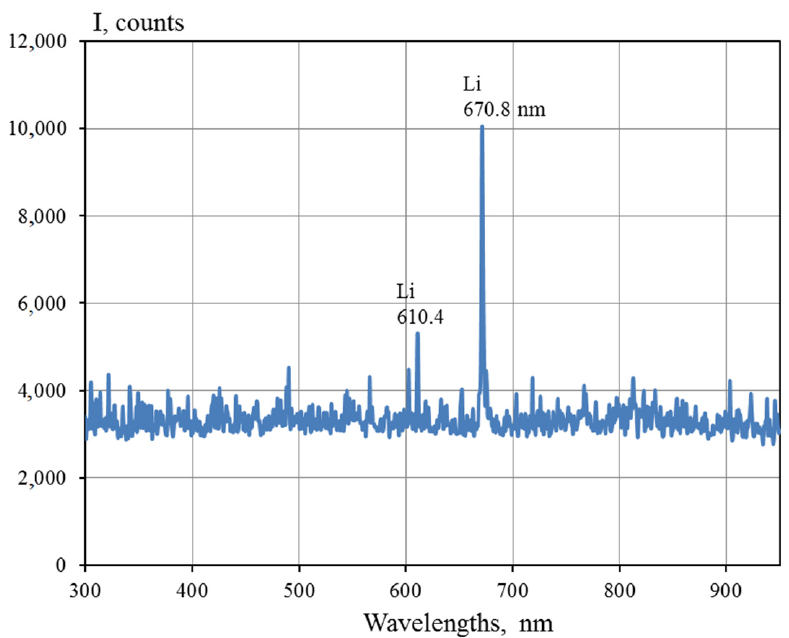
Figure 7. Emission spectrum in argon medium. Initial pressure of Ar is 305 Torr, and lithium layer temperature before the reactor start-up is 710 K.